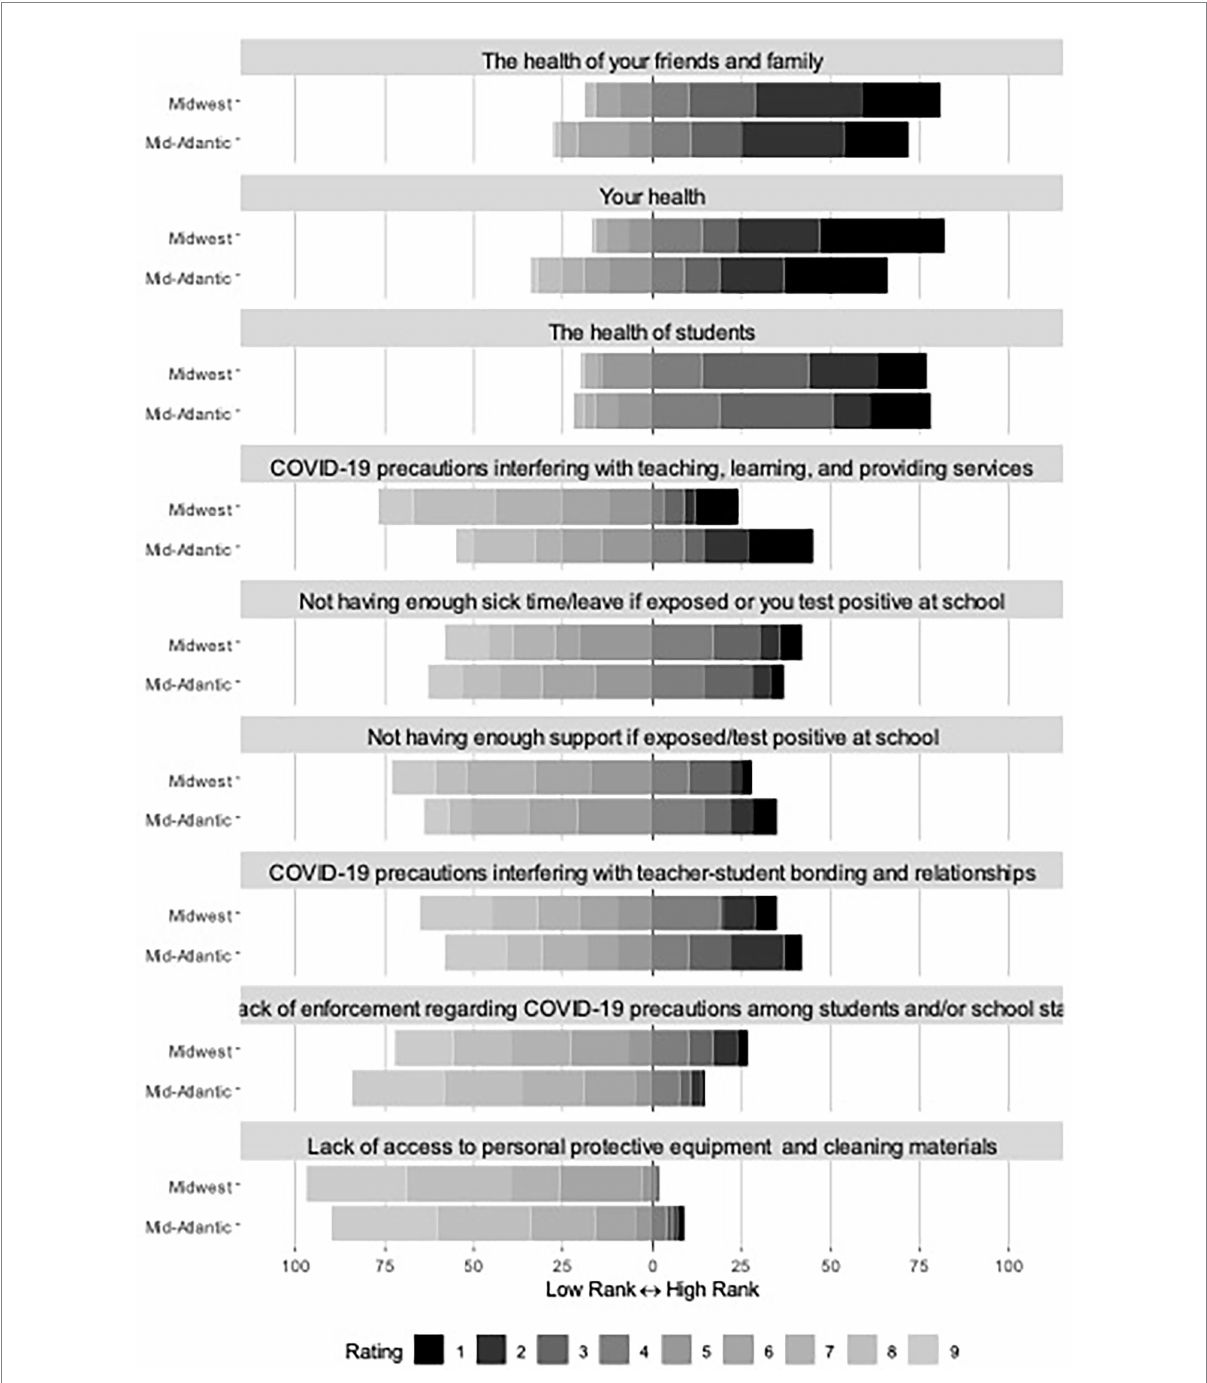
FIGURE 1 Educator ranking of concerns during the COVID-19 pandemic. Items were ranked in order of which educators were most concerned (1) at the time of survey